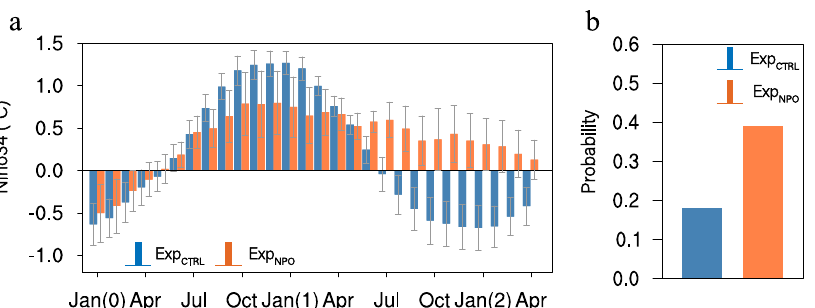
Fig. 5 The impact of the NPO on the evolution of El Niño events in the CGCM experiments. a Ensemble-mean differences in the Niño3.4 index from January(0) to April(2) between the positive NPO forcing and CTRL experiments (red bars). As a contrast, also shown is the ensemble-mean Niño3.4 index of El Niño events in the CTRL experiment (green bars). Error bars indicate the 95% con fi dence intervals. b Probability of multi-year El Niño events in the positive NPO forcing (red bar) and CTRL (green bar) experiments based on 60 ensemble member